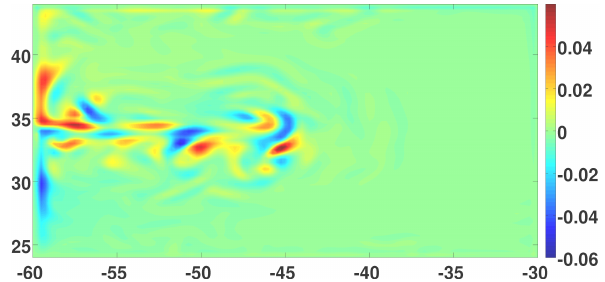
Figure 3. Sea level errors after one forward–backward model inte- gration. The time window is 10 days.